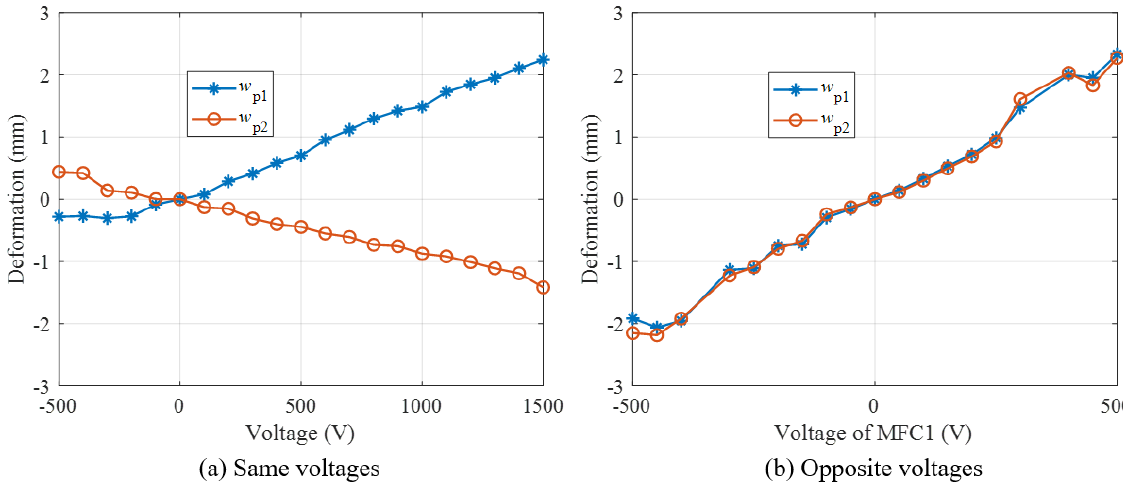
Figure 10. Deflection of the measurement points using bimorph MFC actuators. ( a ) Deflection of the measurement points using bimorph MFC actuators under the same voltages; ( b ) deflection of the measurement points using bimorph MFC actuators under the opposite voltages.